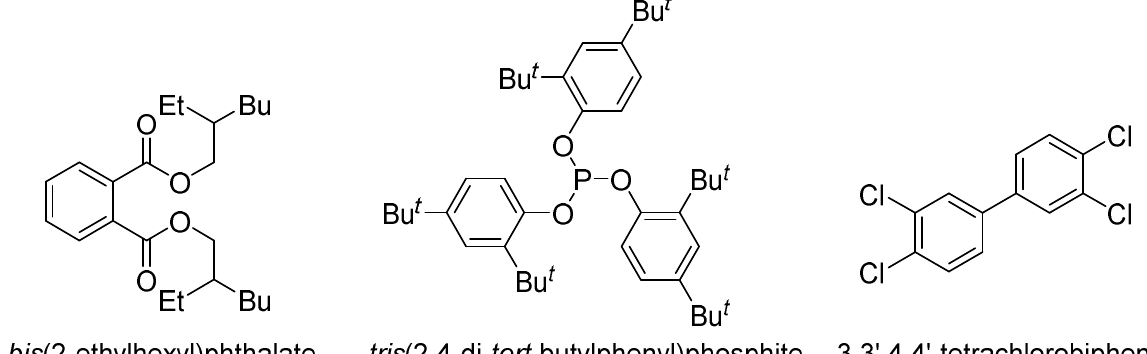
Figure 1. Some common PVC additives.